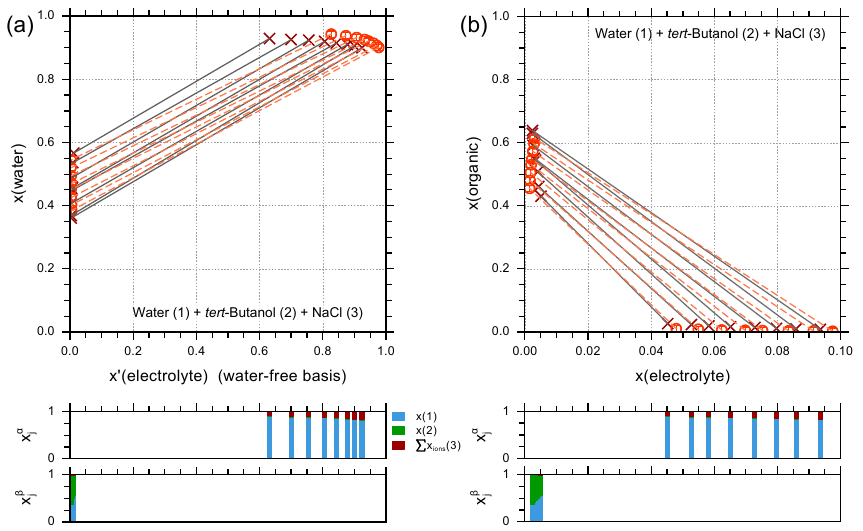
Fig. 5. Experimental and computed LLE phase compositions of the ternary system water (1)+ tert -butanol (2)+NaCl (3) at 298K. Measured tie-line data ( ) by Gomis et al. (1996) and computed compositions ( ) using AIOMFAC with the phase separation prediction module (Zuend et al., 2010). (a) Phase diagram where the abscissa represents the water-free “dry” molar mixture composition, x 0 (NaCl). The solid gray and dashed red lines indicate coexisting phase compositions of the measured and calculated compositions, respectively (non-standard tie- lines in this coordinate system). (b) Phase diagram of the same system, plotted on mole fraction axis, x (NaCl) vs. x ( tert -butanol). In this coordinate system, tie-lines maintain their standard meaning, i.e., initial (unstable) and stable end points are collinear. In (b) , experimental and calculated tie-lines intersect at the initial compositions, x init , used for the phase separation computations. Fig. S0352 (AIOMFAC_output_0395) j H 2 O (1) + 2-Ethoxyethanol (2) + KCl (3)